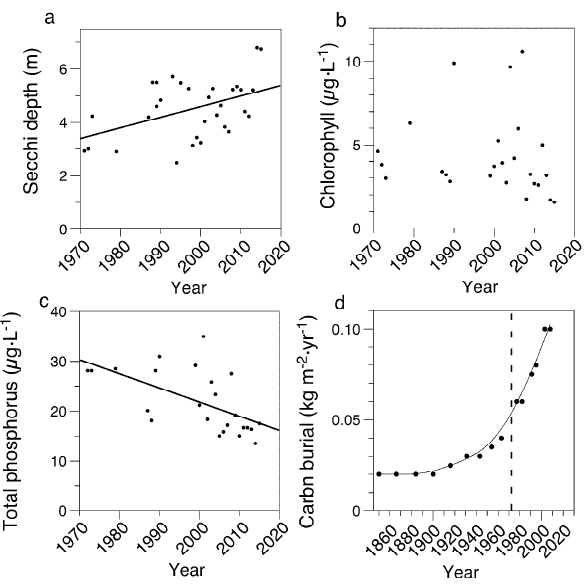
Figure 4. Plots of summer average measurements of Secchi disk depth (( a ) R 2 = 0.22, p = 0.009) chlorophyll ( b ), and total phosphorus (( c ) R 2 = 0.33, p = 0.002) for the period from 1971 to 2015 in Lake West Okoboji. Lines are shown for statistically significant regressions. Rates of carbon burial based on 210 Pb dating of sediment cores from Lake West Okoboji using data from Heathcote et al. [11] for the period 1850–2008 ( d ). The vertical dashed line indicates the year 1971 to identify the period with the field measurements.